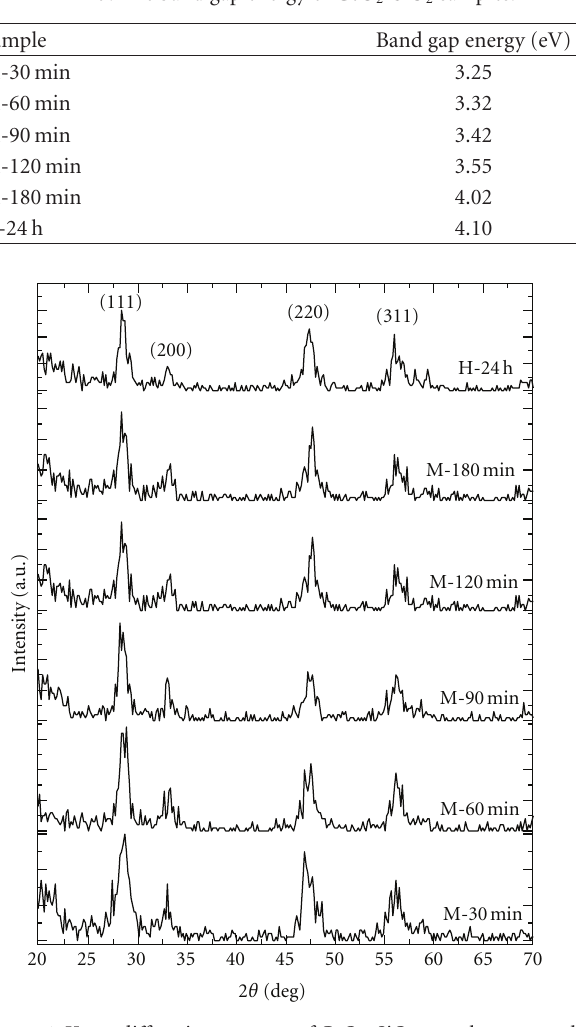
Figure 1: X-ray di ff raction patterns of CeO 2 -SiO 2 samples prepared by di ff erent irradiation times and hydrothermal